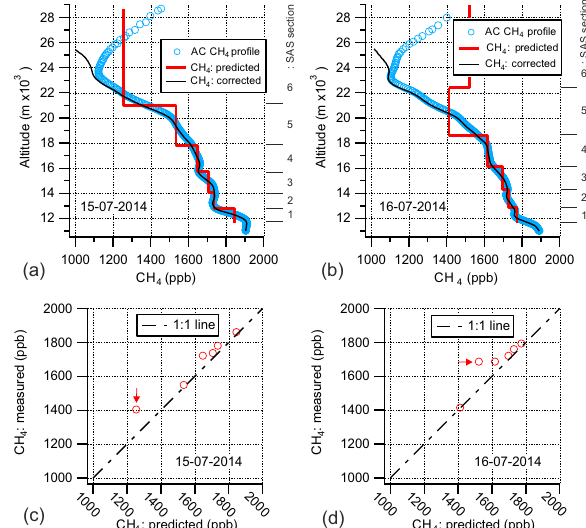
Figure 5. (a) AirCore (AC) CH 4 profile (shown with blue open cir- cles), the corrected AirCore profile (shown with a solid black line), and calculated CH 4 concentration for each section of the SAS for the samples collected on 15 July 2014. (b) The same for the samples collected on 16 July 2014. (c, d) Correlation between the calculated CH 4 concentration and the CH 4 concentration as measured by the CRDS analyzer while extracting the CO 2 from the samples. The measured CH 4 concentration values, for both profiles, are in good agreement with the calculated CH 4 concentrations for all samples, except for the ones (indicated by arrows) corresponding to the upper stratosphere, which are contaminated with leftover fill